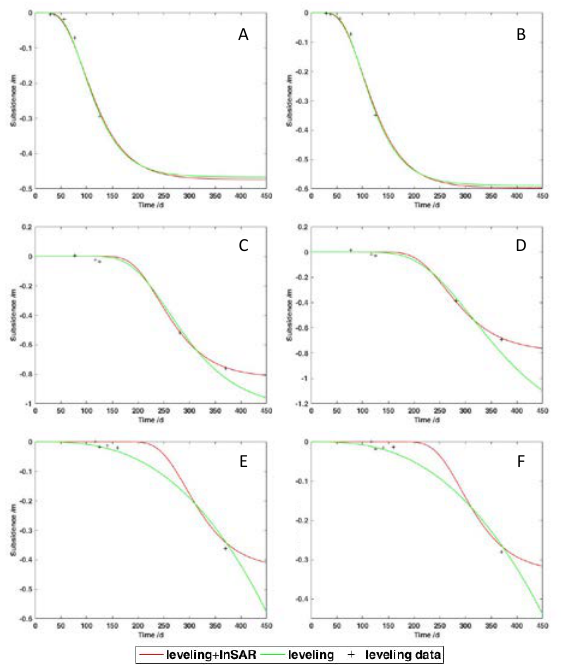
Figure 8. The fitted curve and levelling at five moments As shown in Figure 8, the error between the predicted data obtained by the red curve with the measured data was obviously less than that by the green curve. And the initial subsidence was not zero in points E and F because of the coal mining extraction of advancing positions. To analysis the prediction accuracy of exponent Knothe model quantitatively, the mean errors were calculated between the predicted data with the measured data in six points, which were shown in Figure 4. The mean errors obtained by levelling and SAR in points A, B, C and D were less than the values obtained only by levelling. The mean errors obtained by levelling and SAR in points E and F were bigger than that only by levelling, but the subsidence curve fitted only by levelling was not fit with the actual mining subsidence process and it was meaningless to compare with the errors.